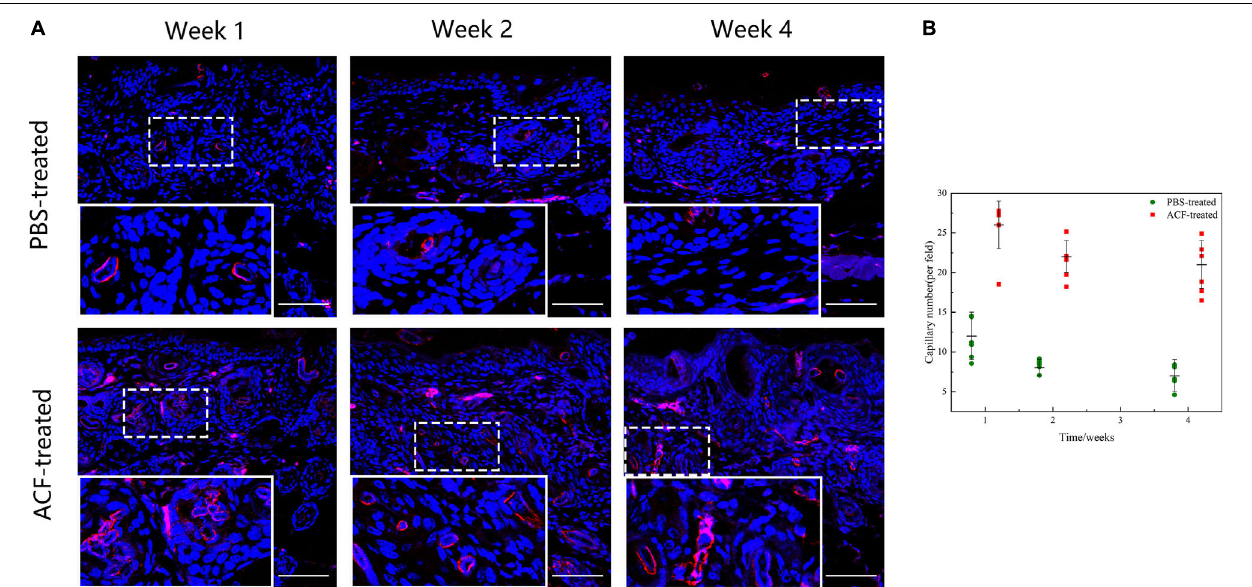
FIGURE 15 | Angiogenesis in mouse skin samples of ACF-treated group and control group. (A) Immunostaining of CD31 + vessels in the dermis of both groups. The expression level of neo-vessels was maximal at week 1 in both groups. (B) Semi-quantitative analysis of CD31 + vessels in the dermis of both groups. The number of CD31 + vessels was significantly higher in the ACF-treated group than in the control group at all-time points. P (week 1) = 1.209E-05, F (week 1) = 0.489; P (week 2) = 1.352E-07, F (week 2) = 0.022; P (week 4) = 3.817E-06, F (week 4) = 0.286. Scale bar = 200 µ